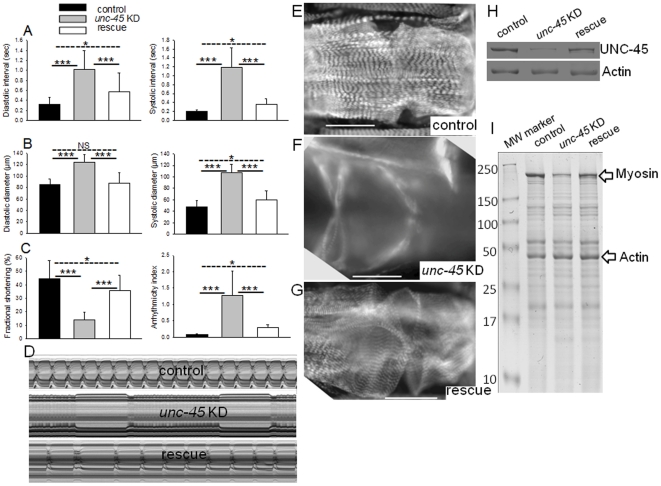
Transgenic over-expression of UNC-45 rescues defects associated with unc-45 KD.(A) Assessment of cardiac diastolic and systolic intervals, (B) diastolic and systolic diameters, (C) % FS and cardiac arrhythmia, in 1 week control, unc-45 KD and rescued old flies. Statistical difference of unc-45 KD from control and rescued as well as between KD and rescued are represented as mean ± SD; where *** =  p<0.001, * =  p<0.05 and NS =  not significant). (D) M-Mode records (10 sec) from hearts of 1 week old control (top), unc-45 KD (middle) and unc-45 rescue (bottom). (E-G) myosin immunofluorescence micrographs of 1 week old control (top), unc-45 KD (middle) and rescue (bottom), scale bar  = 50 µM. (H) Immunoblot (probed with UNC-45 and actin antibodies) and (I) SDS-PAGE shows myosin expression in control, unc-45 KD and rescued fly hearts.